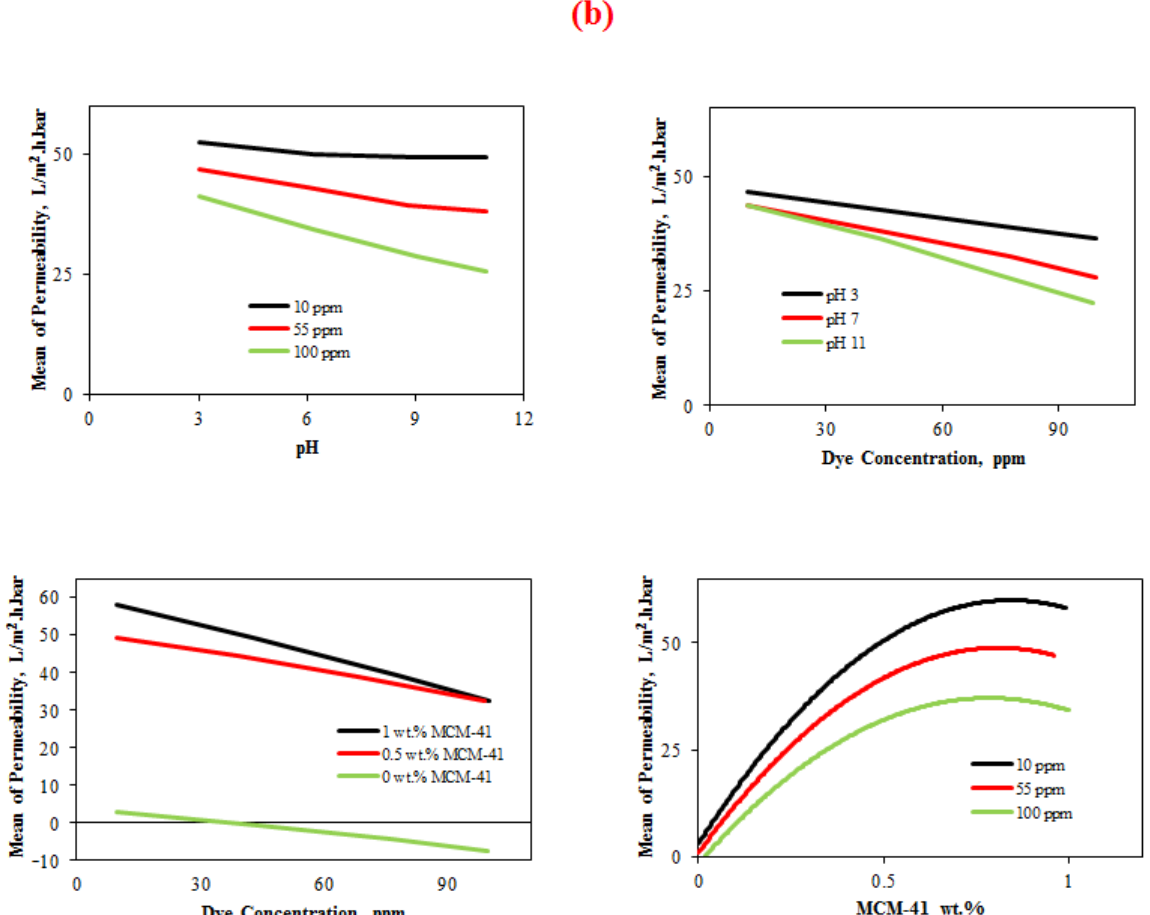
Figure 3. Interaction plots of the pH, concentration, and MCM-41 wt.% on the permeability of ( a ) AB — 210, ( b ) RB dyes.